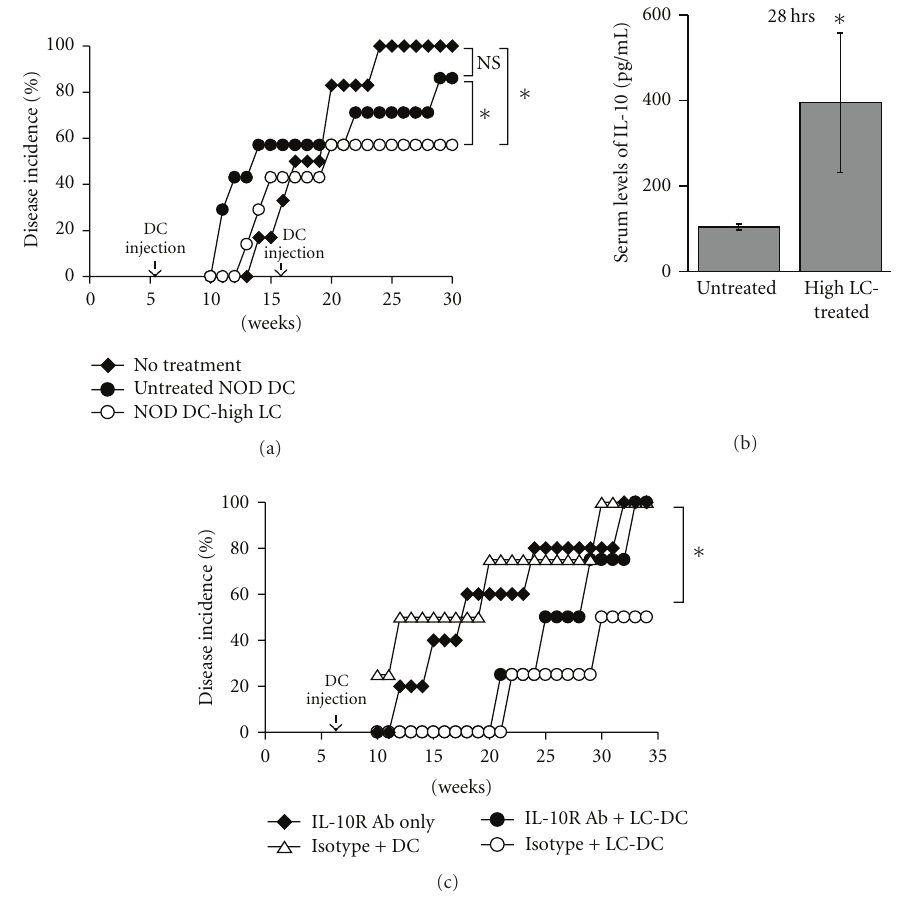
Figure 5: Injection of Lactobacilli -treated DCs into NOD mice confers some protection. Six-week-old NOD mice received two injections of 1 × 10 6 DCs treated with high dose (20 × 10 6 CFU/mL; NOD-high LC) of LC at 6 and 16 weeks of age ( n = 4–6) and blood glucose was measured weekly and diabetes incidence determined (a). Sera from NOD mice uninjected or injected with DCs treated with high-dose LC (high LC) were collected at 28 hrs after injection, and tested for the presence of IL-10 by ELISA (b). Six-week-old NOD mice left uninjected or injected with 1 × 10 6 untreated DCs ( n = 4-5) or DCs treated with high dose of LC ( n = 4) received anti-IL-10R or isotype control antibodies, and blood glucose was measured weekly and diabetes incidence determined (c). ∗ indicates a significant di ff erence at P < .